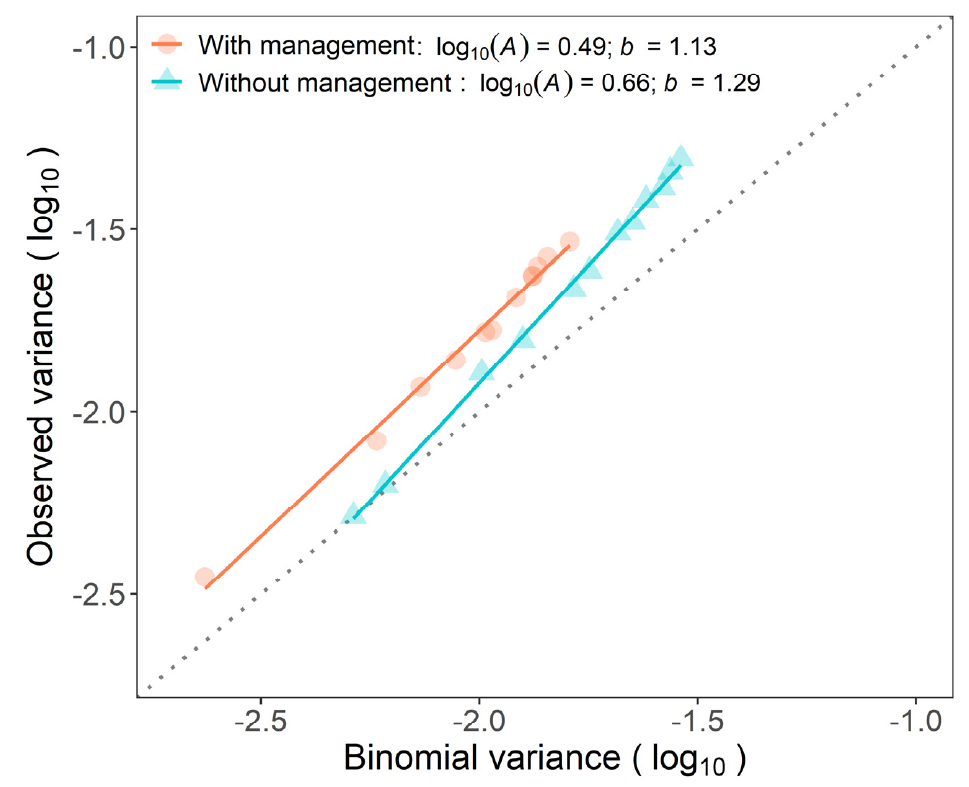
Figure 4. Binary power law of successive assessments for incidence of Fusarium wilt of banana from April 2017 to February 2019 in two plots, with and without management of weevil borer ( Cosmopolites sordidus , WB).